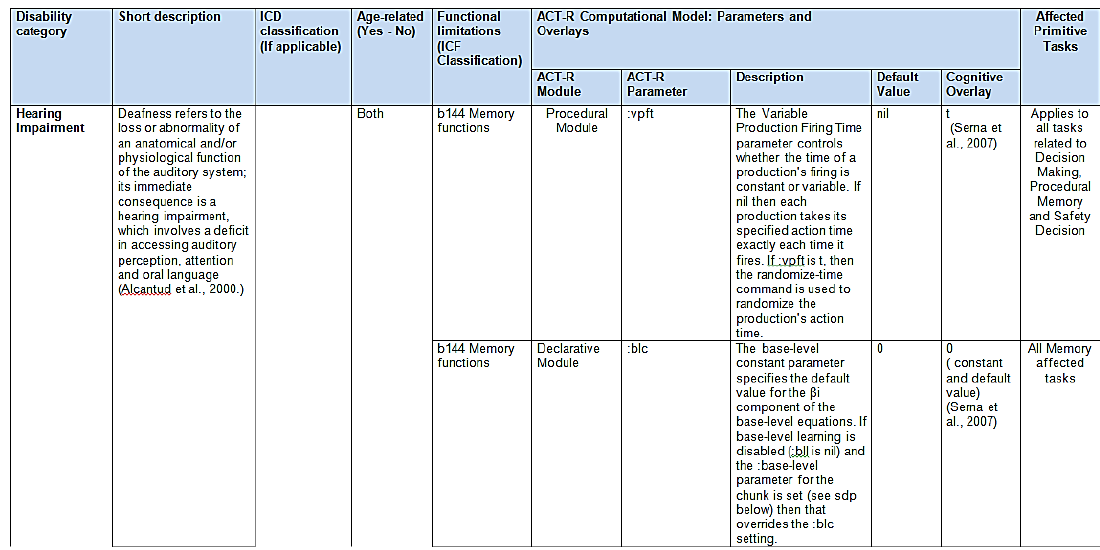
Figure 6. Structure of the Generic Cognitive Virtual User Model. Notes: Schneider et al. [44], Stevens et al. [45], Stenklev and Laukli [46].